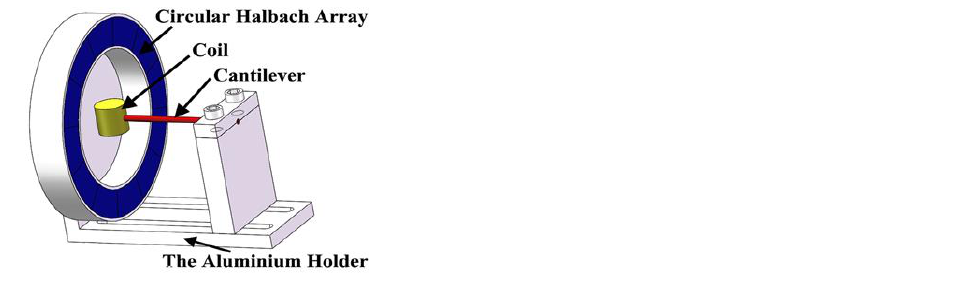
Figure 6. A circular Halbach array harvester that implements a moving coil via a cantilever [55].